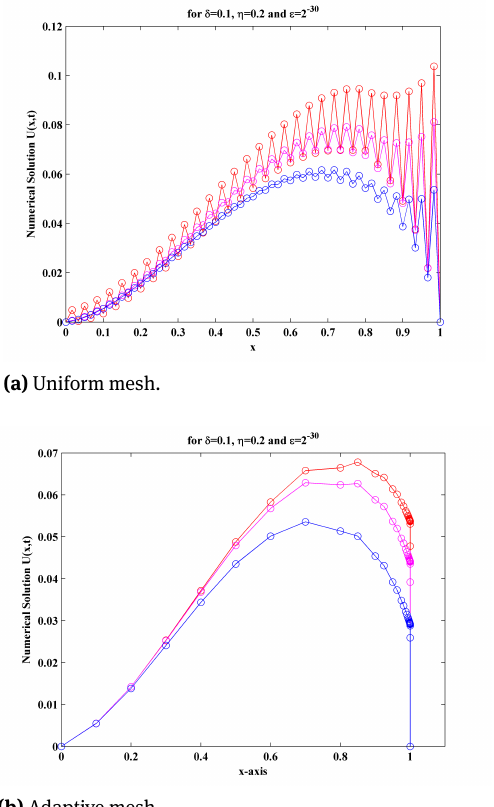
Fig. 9: Surface plot of example 5.3, using adaptive mesh for differ- ent values of ϵ , δ and η